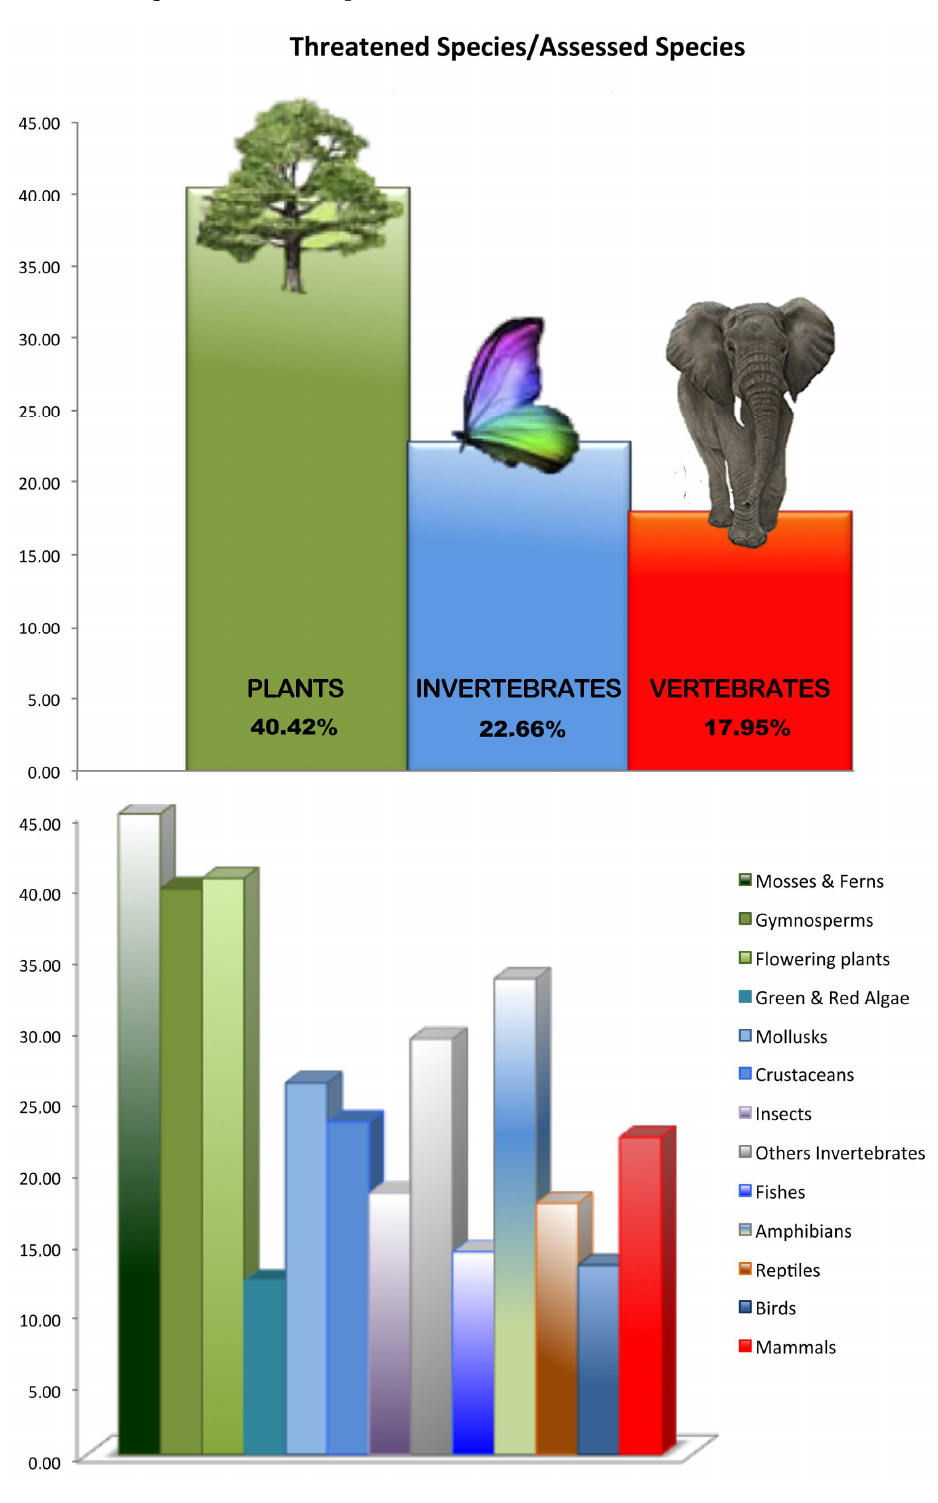
Figure 2. Percentage of the current number of threatened species evaluated in relation to the overall number of species assessed in the major groups of organisms by the IUCN animal Red list [94].